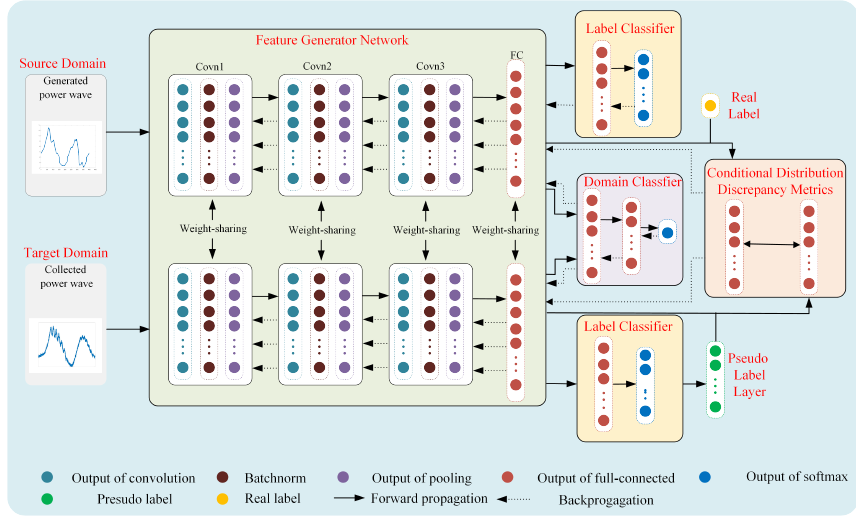
Figure 3. The framework of the proposed